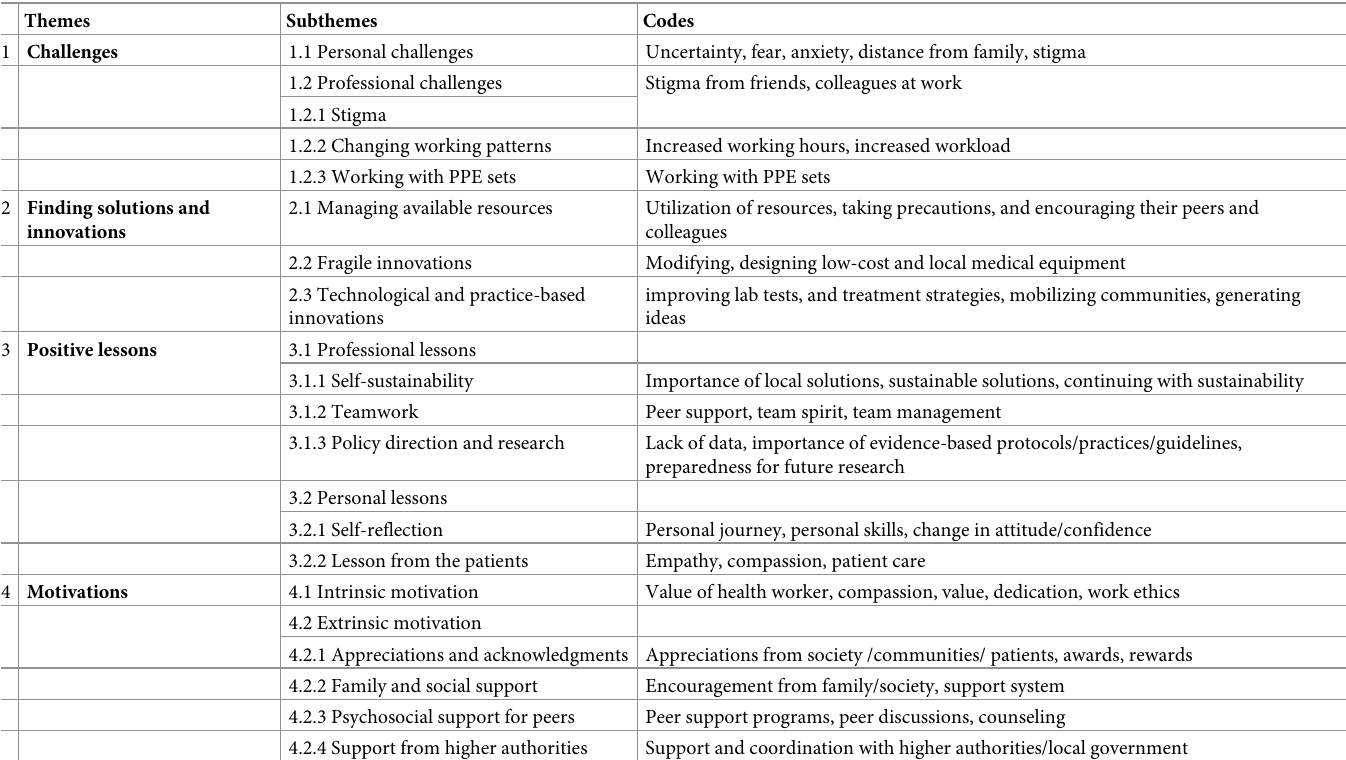
Table 1. Themes, subthemes, and codes on positive deviance traits among frontline health workers during COVID-19.